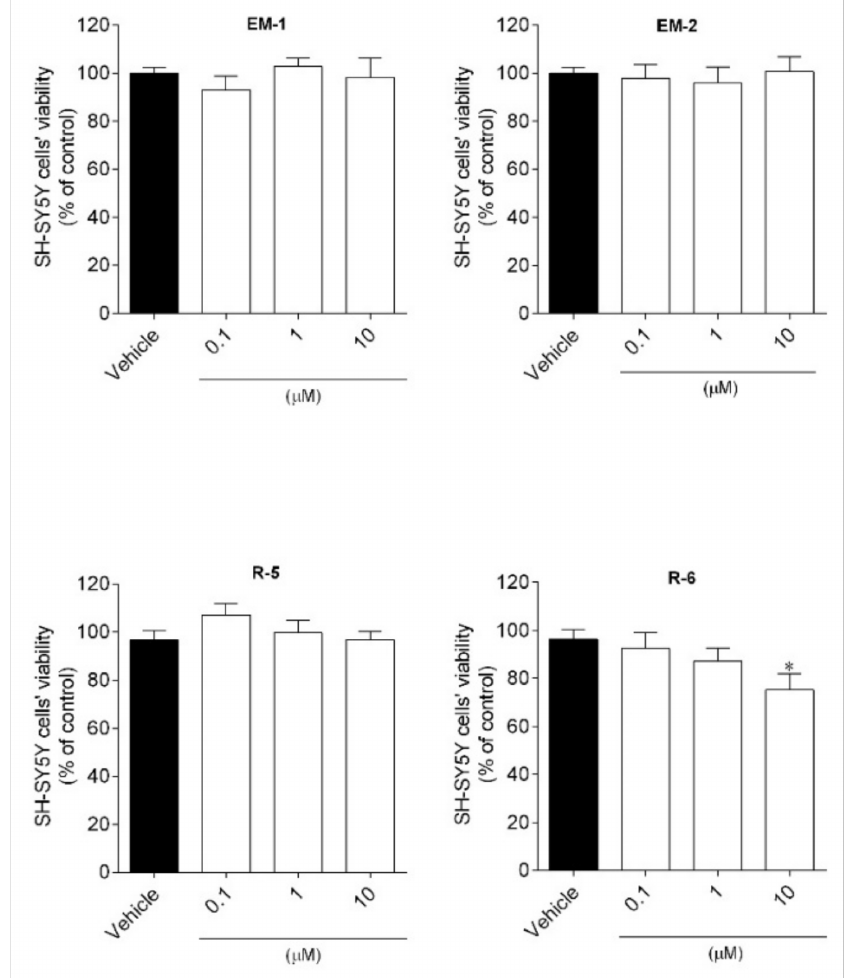
Figure 3. SH-SY5Y cells’ viability when exposed 24 h to peptides (0.1–10 µ M). The values in each column represent the mean ± SEM of 3 or 4 independent experiments. Symbols represent significant differences (ANOVA, Dunett’s test, * p < 0.05) when compared to: